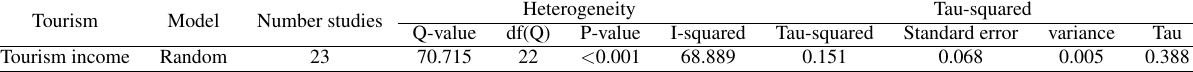
Table 1 Effect value homogeneity test results (Q statistics)